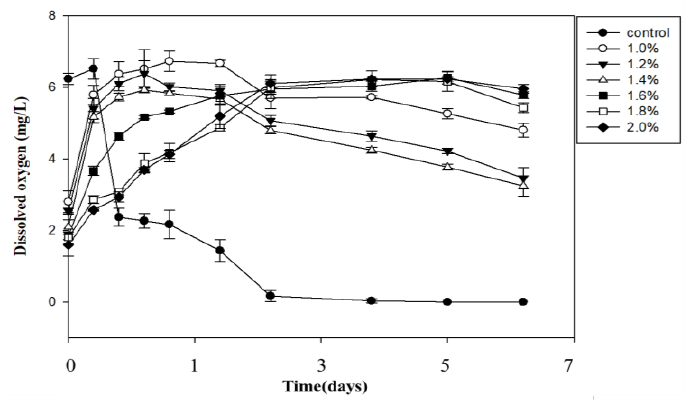
Figure 4. Effect of alginate concentration on the release profile of dissolved oxygen.